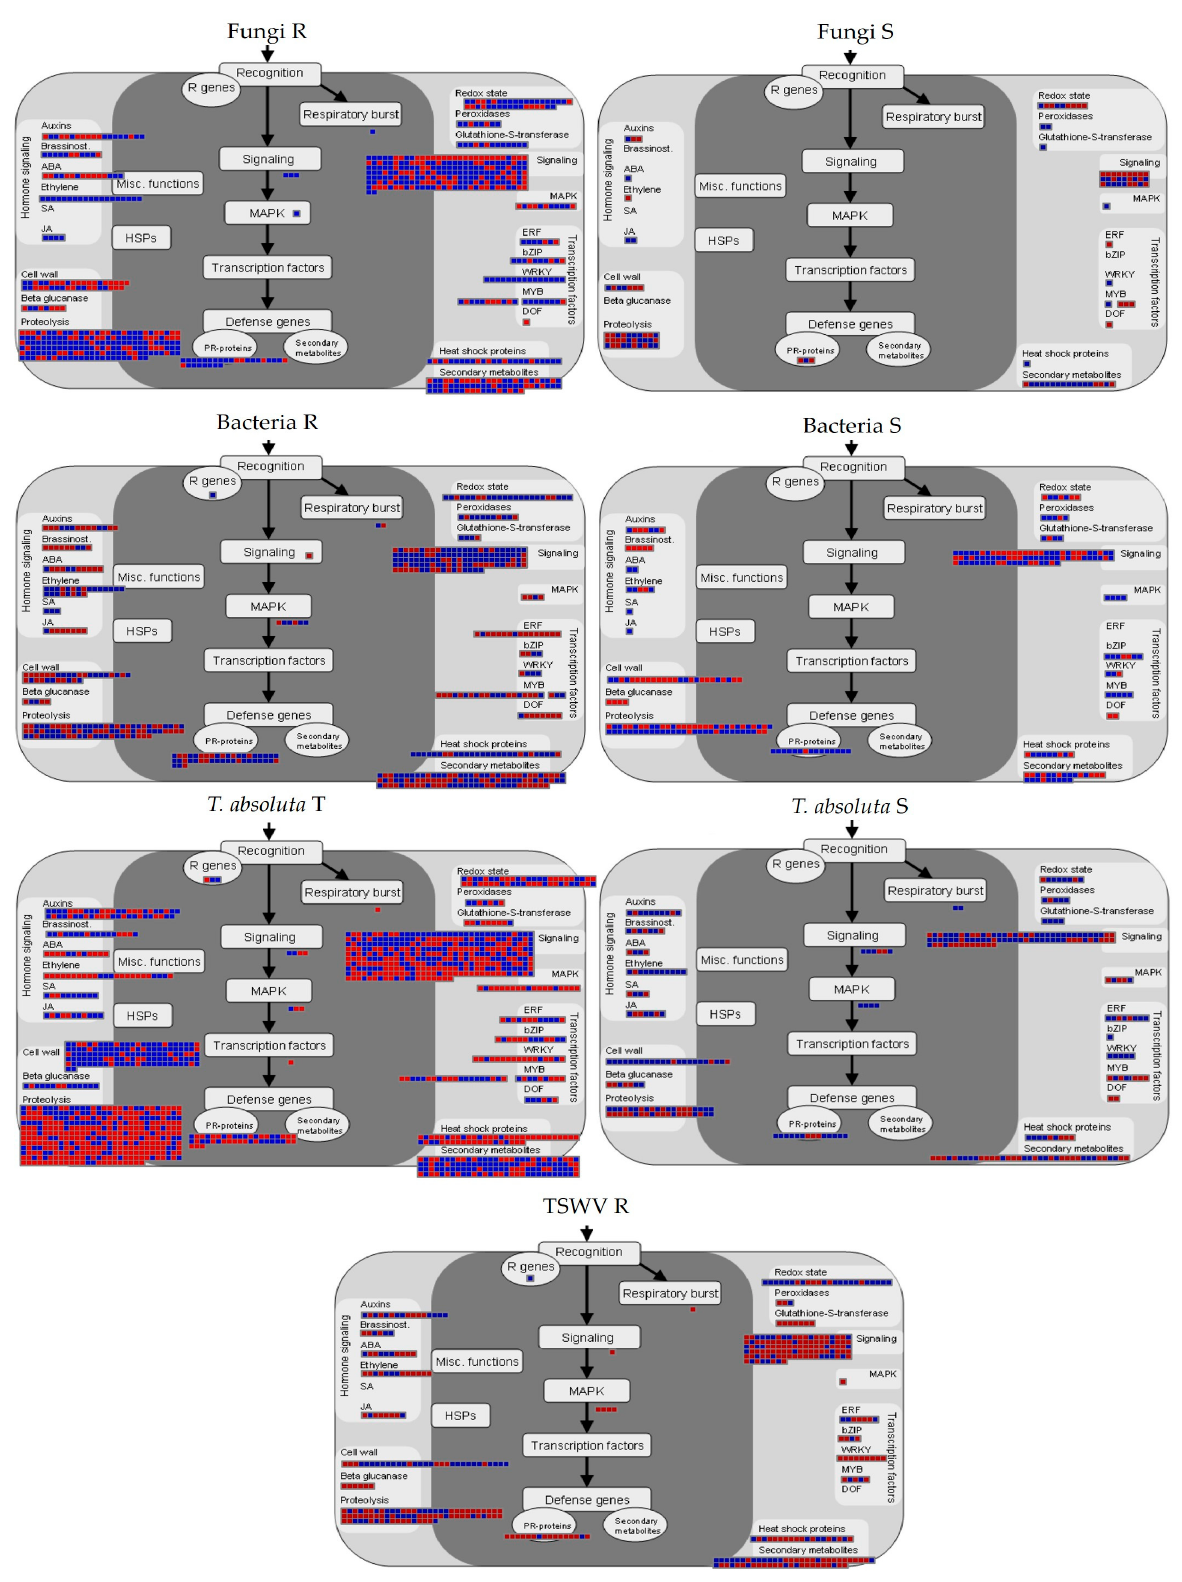
Figure 3. Genes putatively involved in biotic stress response under fungi, bacteria, TSWV, and T. absoluta infections. Blue: upregulated, red: downregulated genes . R= resistant; S= susceptible; T= tolerant genotype.